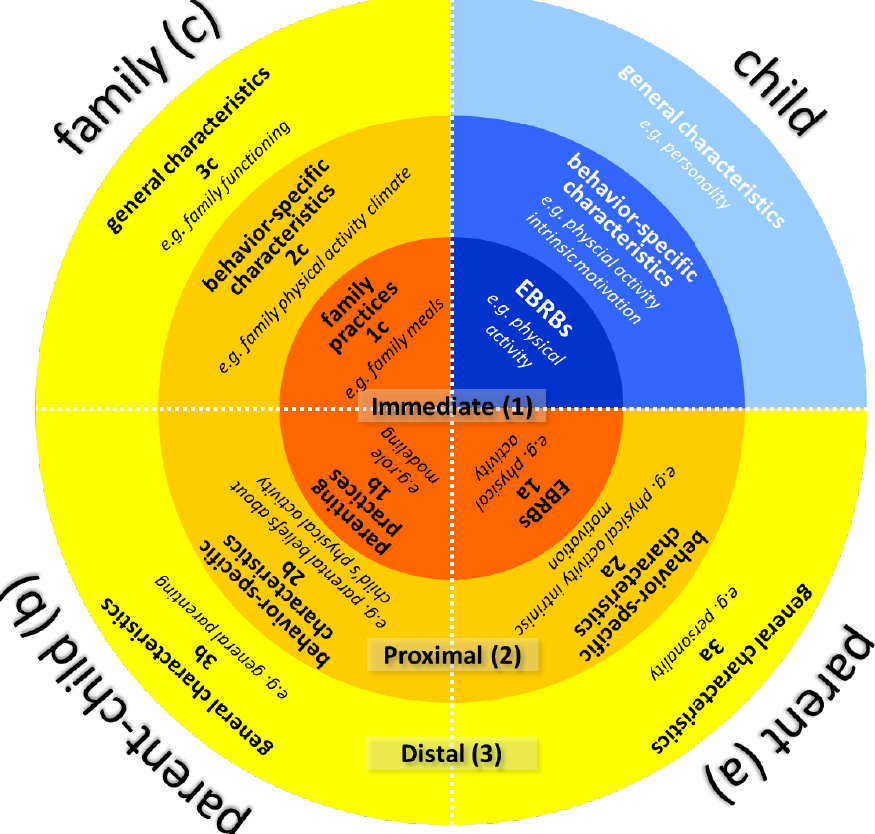
Figure 1. Levels of Interacting Family Environmental Subsystems (LIFES).